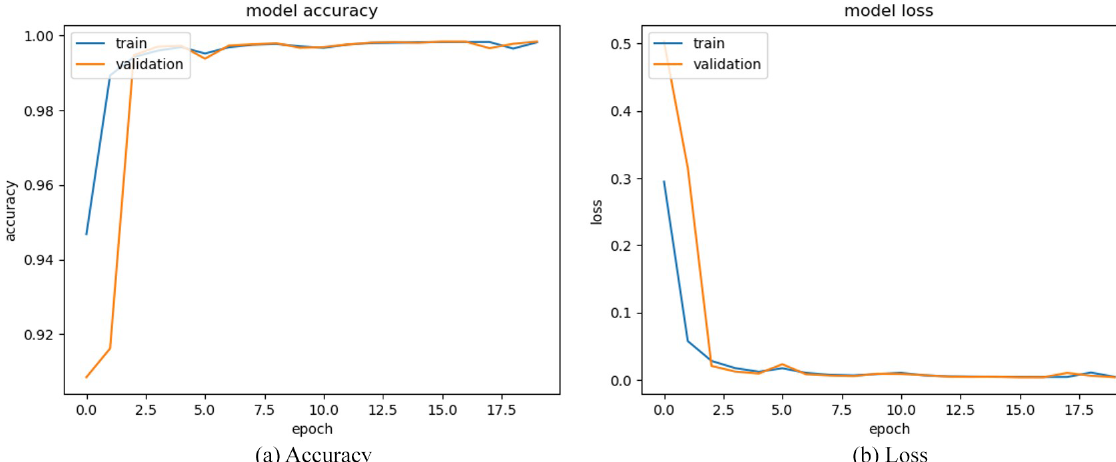
Figure 8. Accuracy and loss function curves on the dataset SN1.